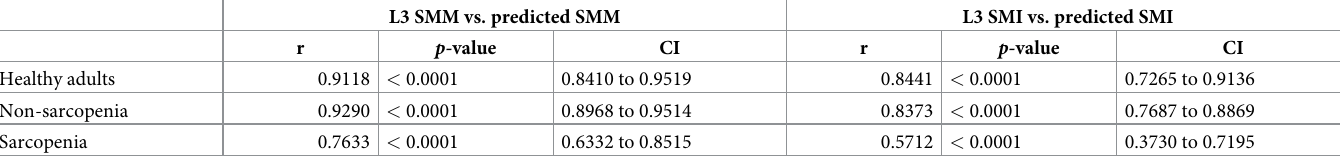
Table 4. Correlation between actual SMM and predicted SMM at L3 in each group.